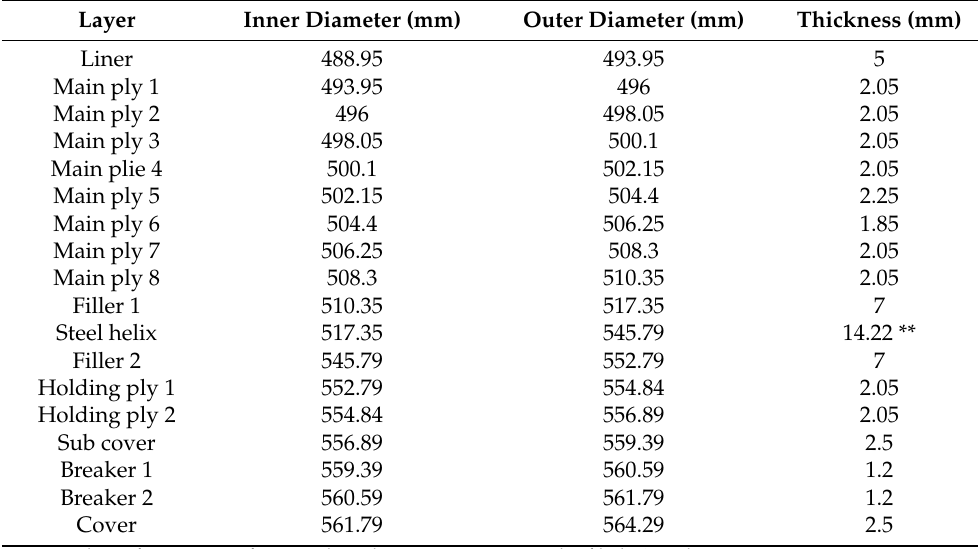
Figure 4. Helix reinforcement of the marine hose, showing ( a ) isotropic, and ( b ) side views. Table 3. Marine hose model